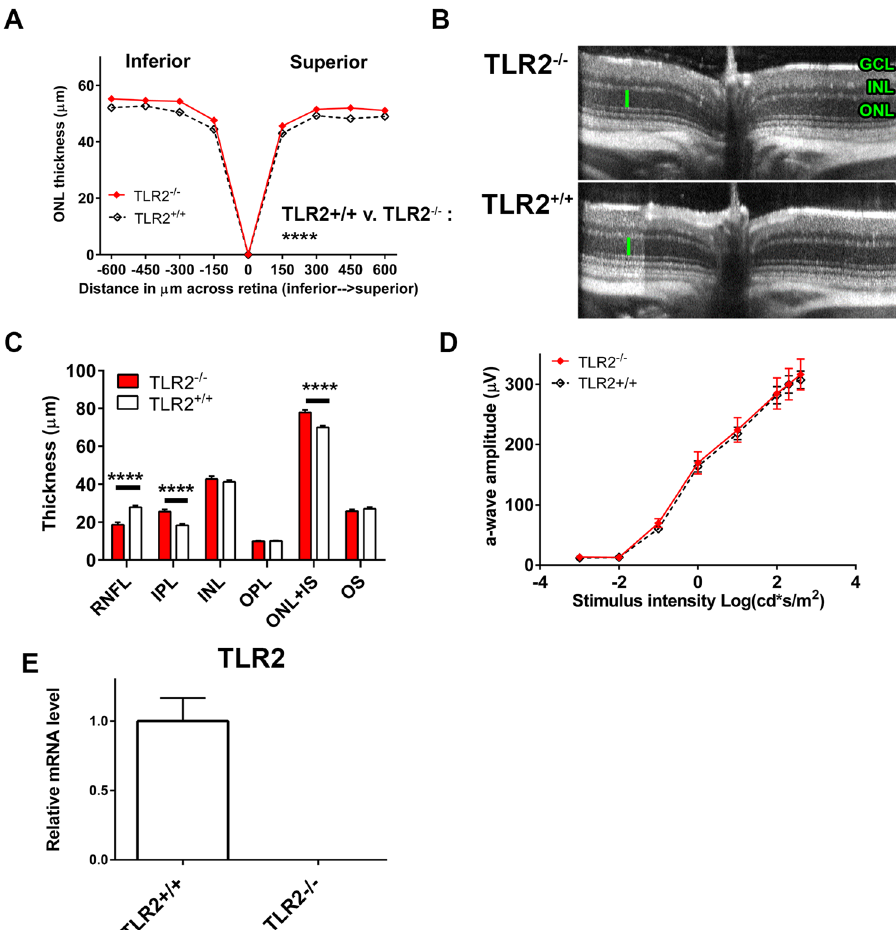
Figure 1. Retinal structure and function in TLR2 − / − mice. ( A ) ONL thickness of 6 to 10-week-old TLR2 − / − and TLR2 + / + mice is plotted versus distance from the optic nerve. ( B ) Representative OCT b-scans of TLR2 − / − and TLR2 + / + mice. ( C ) Thickness of retinal layers was measured using auto-segmentation in Diver software. ( D ) Scotopic ERG a-wave amplitudes of 4–8 week old TLR2 − / − and TLR2 + / + mice. ( E ) TLR2 mRNA expression to confirm TLR2 knockout in TLR2 − / − mice. Statistics: Two-way ANOVA (multiple comparisons were done for C). ( A – D ) n = 15–25 from three independent experiments. ( E ) n = 6–8 total from two independent experiments). The “No LD” group is made up of an average of all mice (all genders and genotypes) in the absence of light